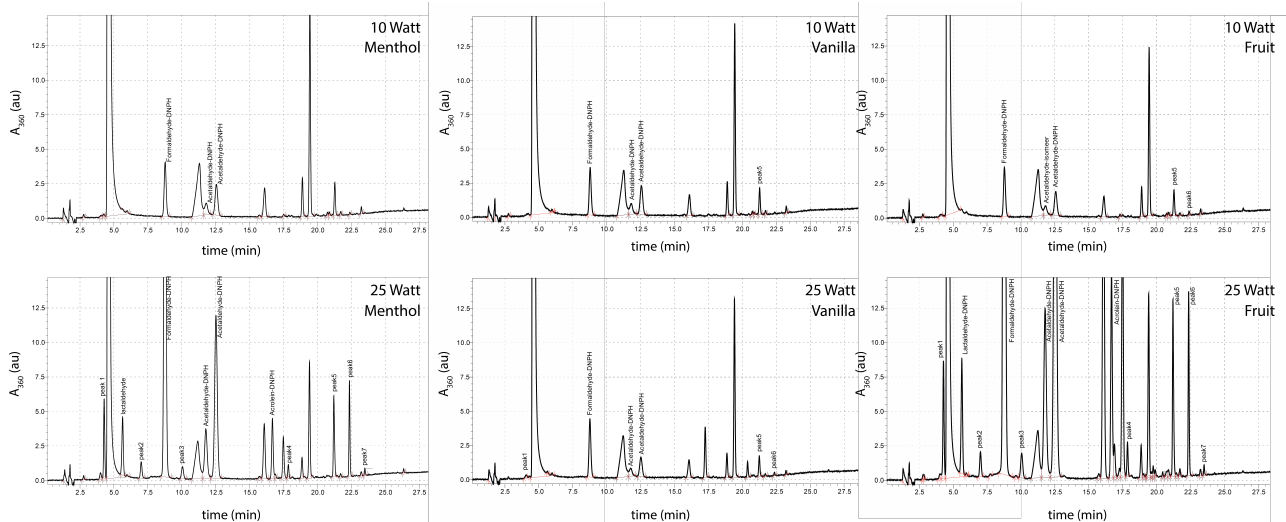
Figure 2. HPLC-DAD ( λ = 360 nm) chromatograms of DNPH-derived carbonyl compounds in e-cigarette emissions for the three different e-liquids at 10 W and 25 W power using a 1.6 Ω coil. The two peaks named “acetaldehyde-DNPH” are isomers. Relevant peaks of unknown chemical identity are labeled “peak1” to